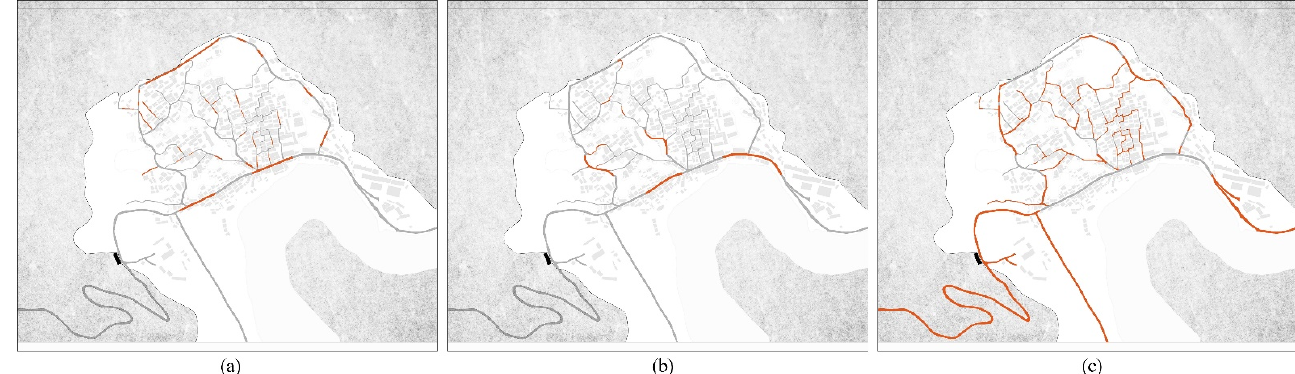
Figure 16. Distribution of the main streets, straight streets, and crooked streets in High chair Village. ( a ) main streets; ( b ) straight streets; and ( c ) crooked streets.